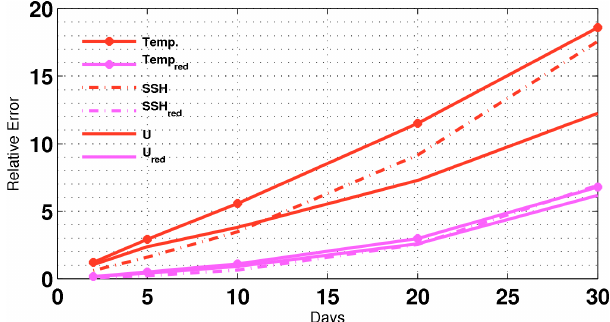
Figure 1. Errors in the initial condition after one forward–backward model integration perfectly initialised and without nudging. Red curves were obtained using the same diffusion coefficients as in the = − 8 × 10 10 m 4 s − 1 and ν t,s = − 4 × reference experiment ( ν u,v h h 10 11 m 4 s − 1 ) and magenta curves were obtained using reduced dif- = − 8 × 10 9 m 4 s − 1 and ν t,s = − 8 × 10 10 m 4 s − 1 ). The fusion ( ν u,v h h abscissa represents the length of the time